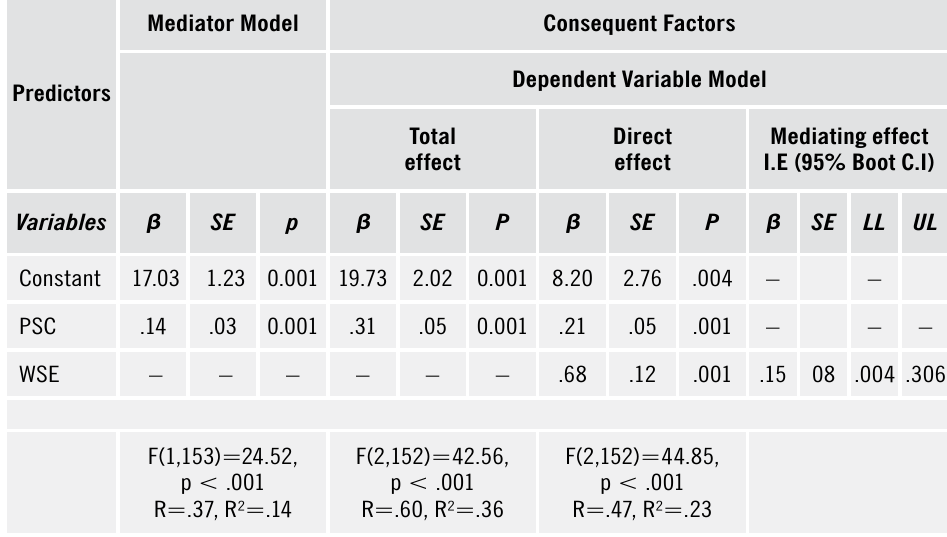
Table 2. Testing the mediating effect of work self-efficacy in the psychosocial safety climate: workplace safety behaviors